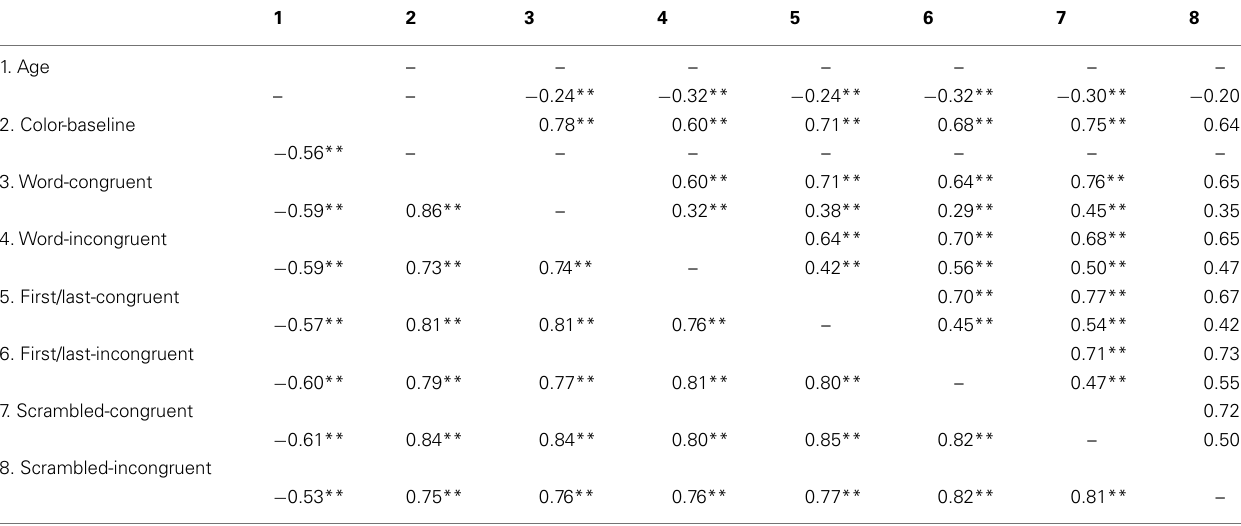
Table 3 | Correlations among scores and